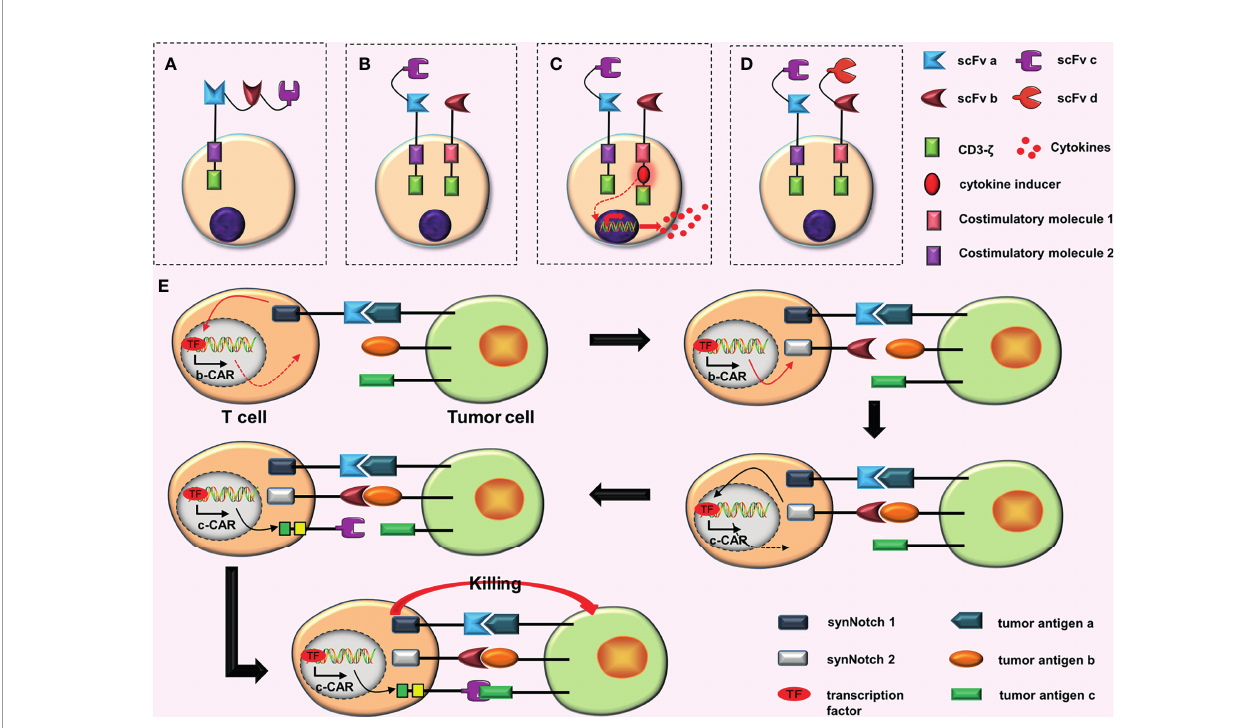
FIGURE 2 | Some conjectures about CARs containing three scFvs. (A) Connecting three scFvs in tandem. (B) In dual-signaling CARs, one CAR is replaced by a TanCAR. (C) One of the dual-signaling CARs is replaced with a TanCAR, and the other is upgraded to a fourth-generation CAR. (D) Both CARs in dual-signaling CAR are replaced with tandem CARs. (E) At fi rst, synNotch 1 receptor is activated after binding to tumor antigen (a), and the activated synNotch 1 receptor induces the expression of synNotch 2 receptor. Then synNotch 2 receptor binds to tumor antigen (b), which induces the expression of c-CAR; c-CAR can bind to the tumor antigen (c); fi nally, the CAR-T cell is